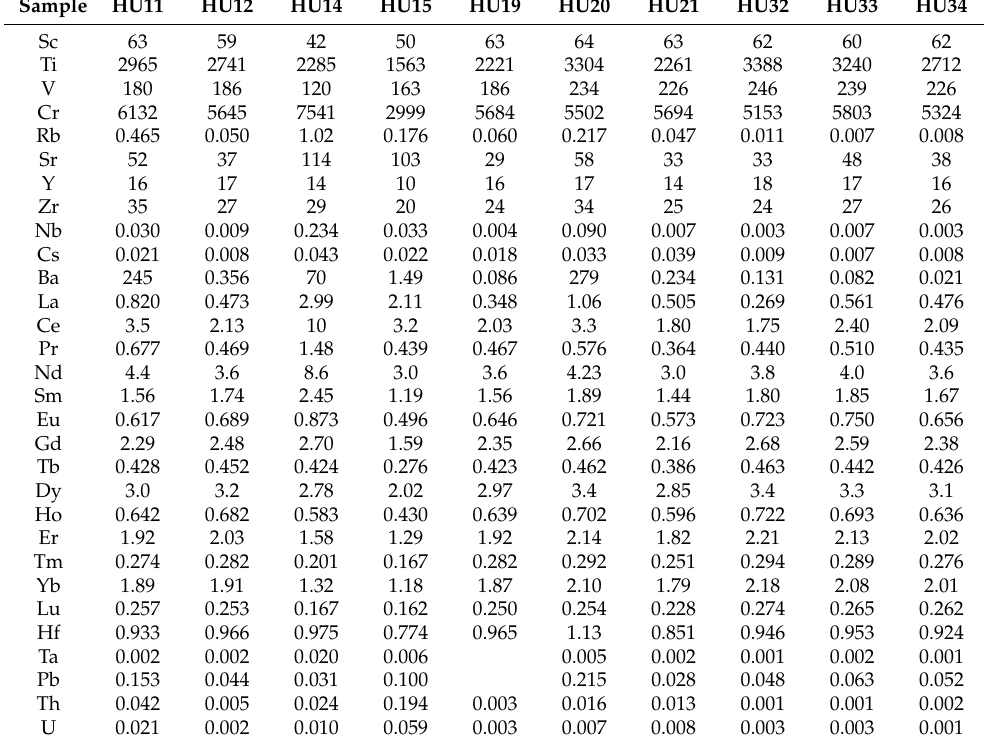
Table 2. Average trace elements composition of Huanul clinopyroxenes. Values are reported in